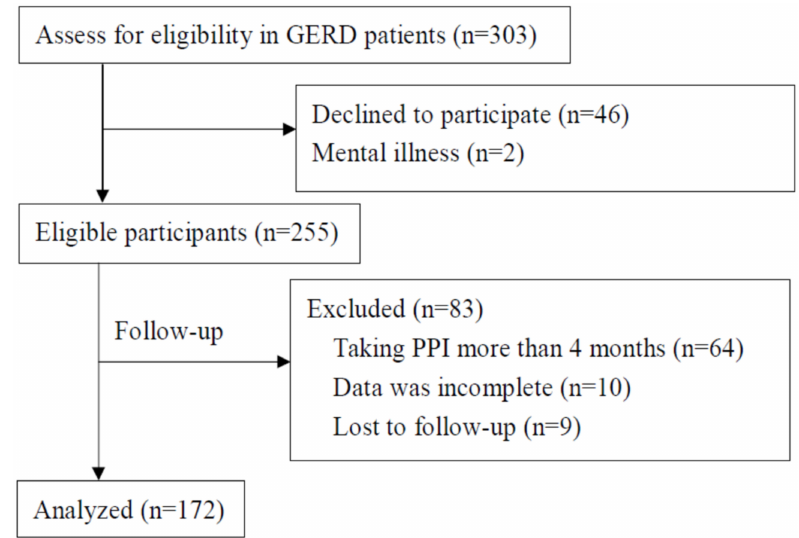
Figure 1. Flowchart depicting sample selection for the study. GERD, gastroesophageal reflux disease; PPI, proton-pump